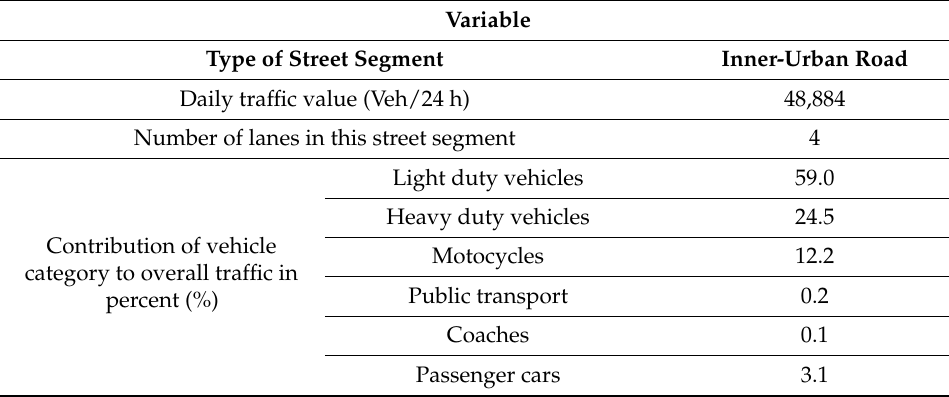
Table 2. Distribution of traffic flow.